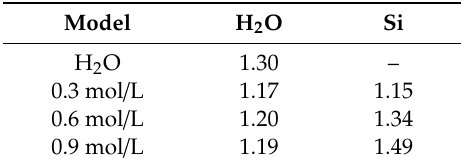
( b ) Figure 9. Screenshots of two models of water molecules at 800 ps. ( a ) Silicone emulsion, ( b ) Silicone molecules arranged on the surface.